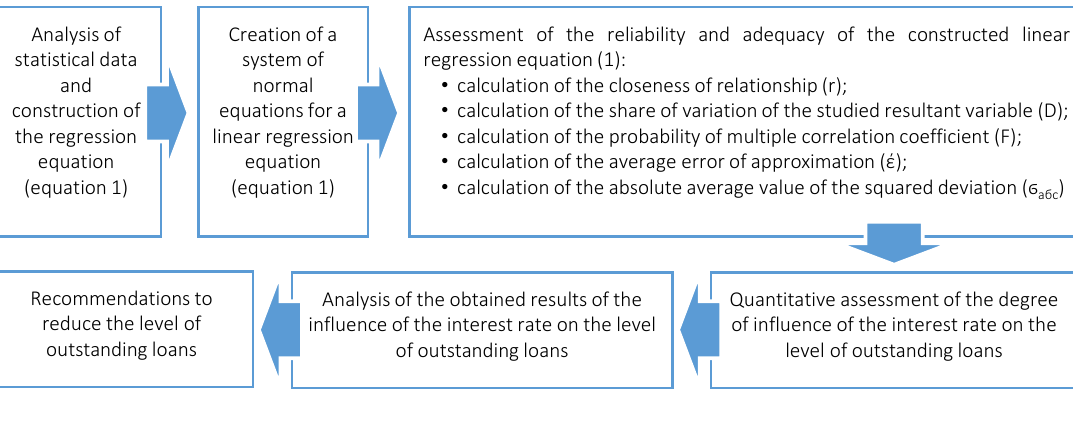
Figure 1. Algorithm for detecting the impact of interest rate on the level of outstanding